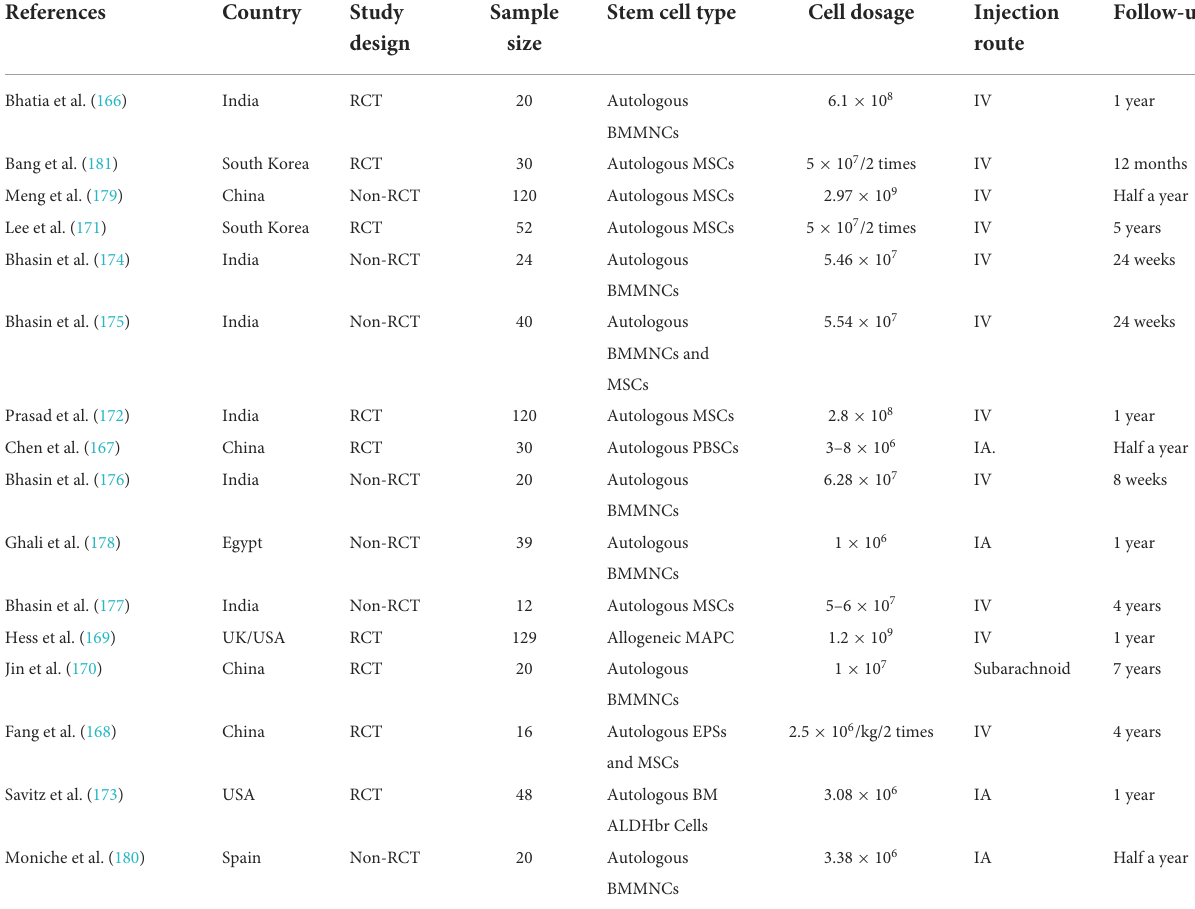
TABLE 3 Main characteristics of the clinical study assessing stem cells in treating ischemic